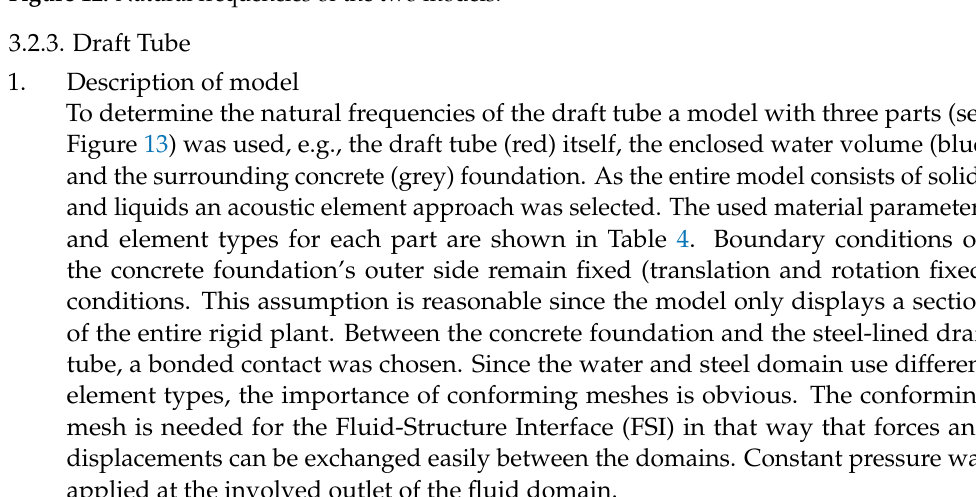
Figure 12. Natural frequencies of the two models.